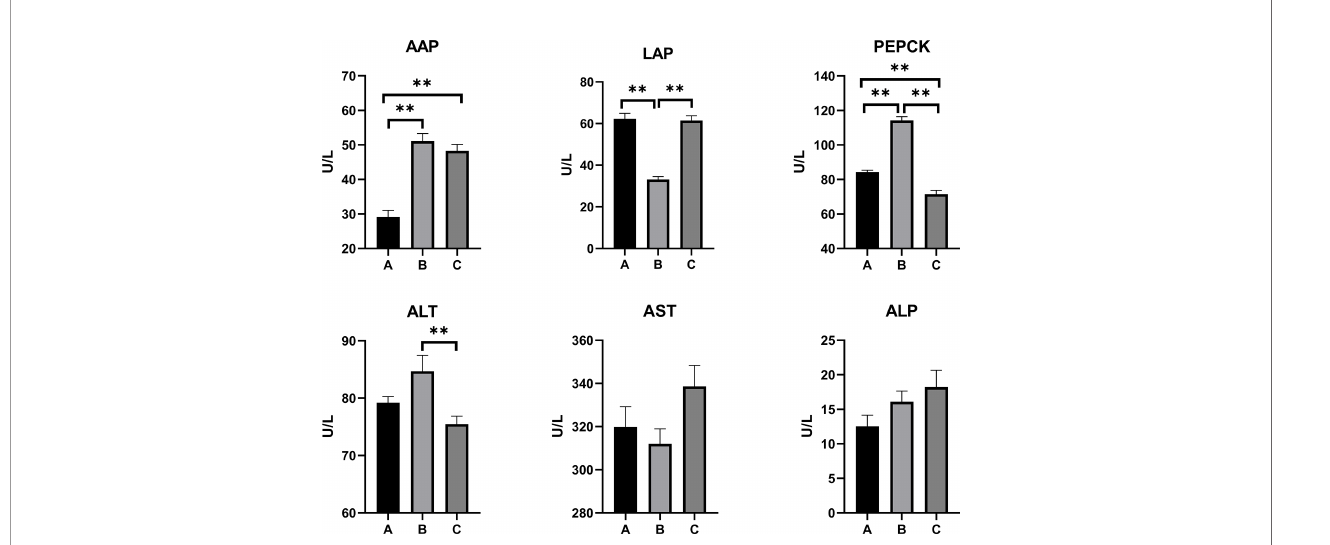
FIGURE 1 | Effects of OTA and AFB1 on serum biochemical parameters of pullets after 42 days (n = 6, mean ± SEM), including AAP, LAP, PEPCK, ALT, AST, and ALP. Groups A, B, and C are the control group, the pair-feeding group, and the OTA+AFB1 group, respectively. Data were analyzed with ANOVA and Tukey ’ s HSD, and signi fi cant differences were de fi ned as ** p < 0.01. OTA, ochratoxin A; AFB1, a fl atoxin B1; AAP, alanine aminopeptidase; LAP, leucine aminopeptidase; PEPCK, phosphoenolpyruvate carboxykinase; ALT, alanine aminotransferase; AST, aspartate aminotransferase; ALP, alkaline phosphatase; HSD, honestly signi fi cant difference.